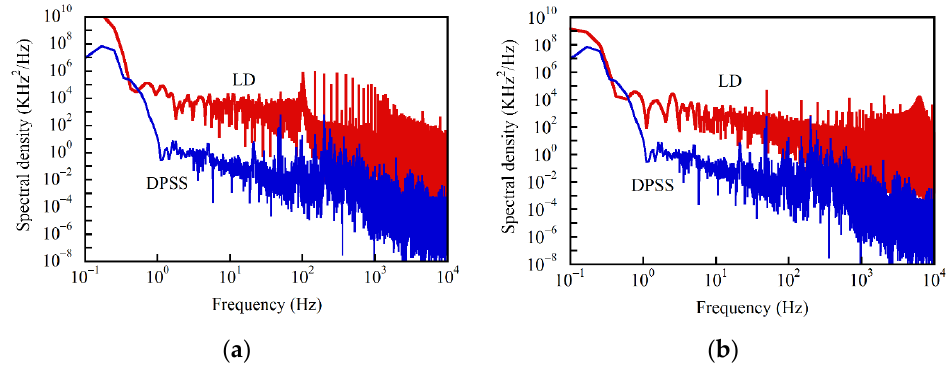
Figure 5. Power spectral density (shown in red) of the frequency fluctuations of the LD output when it was driven with ( a ) current source A and ( b ) current source B. The power spectral density obtained from a diode-pumped solid-state (DPSS) laser is also plotted in blue in each figure.